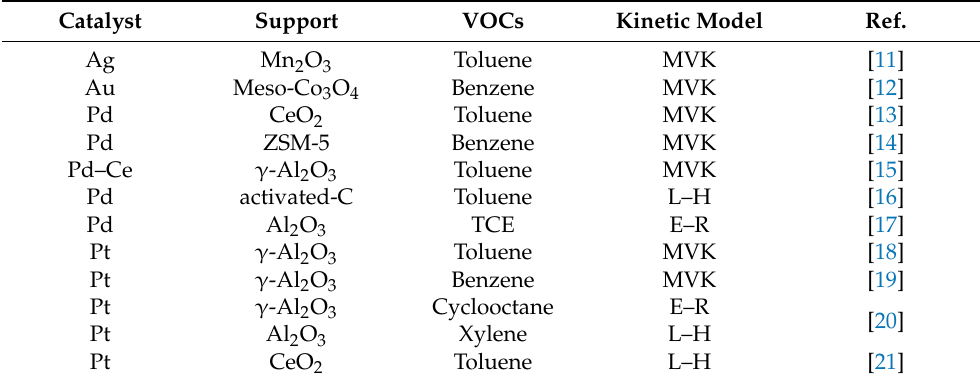
Figure 1. Kinetic models of catalytic VOC oxidation: ( a ) L–H model, ( b ) E–R model, and ( c ) MVK model. Table 1. Kinetic models of catalytic VOC oxidation.